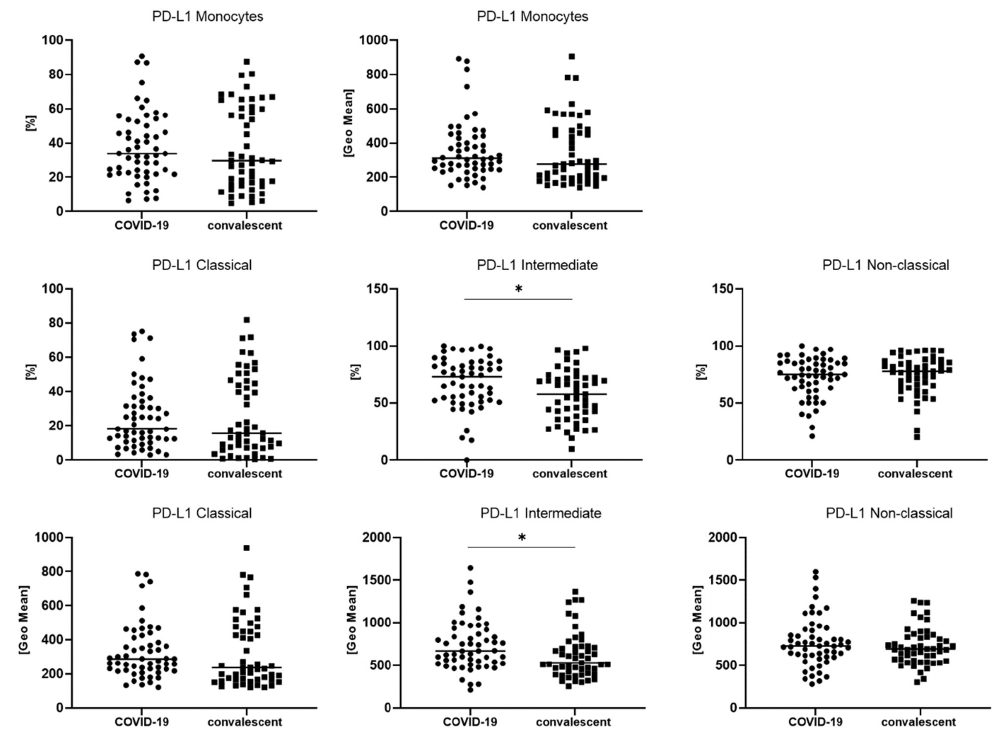
Figure 3. The differences between COVID-19 and convalescent patients for geometric mean expres- sion of PD-L1 on classical, intermediate and non-classical monocytes. Graphs show the median values ( − ). Significant differences in the cell proportion between COVID-19 and convalescent patients in the Mann–Whitney U test presented as * ( p < 0.05).